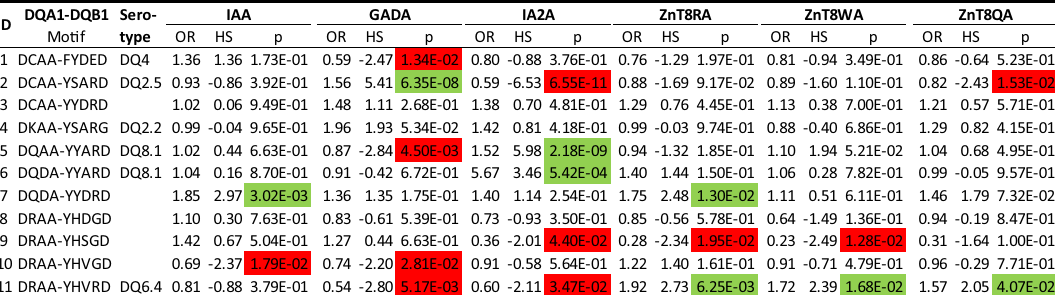
Table 6. Association analysis of DQ motifs with elevated autoantibody levels among all patients (with five or more subjects): estimated odds ratio, haplotype score, and p-value, across all motifs with six autoantibodies (IAA, GADA, IA2A, ZnT8RA, ZnT8WA and ZnT8WA).